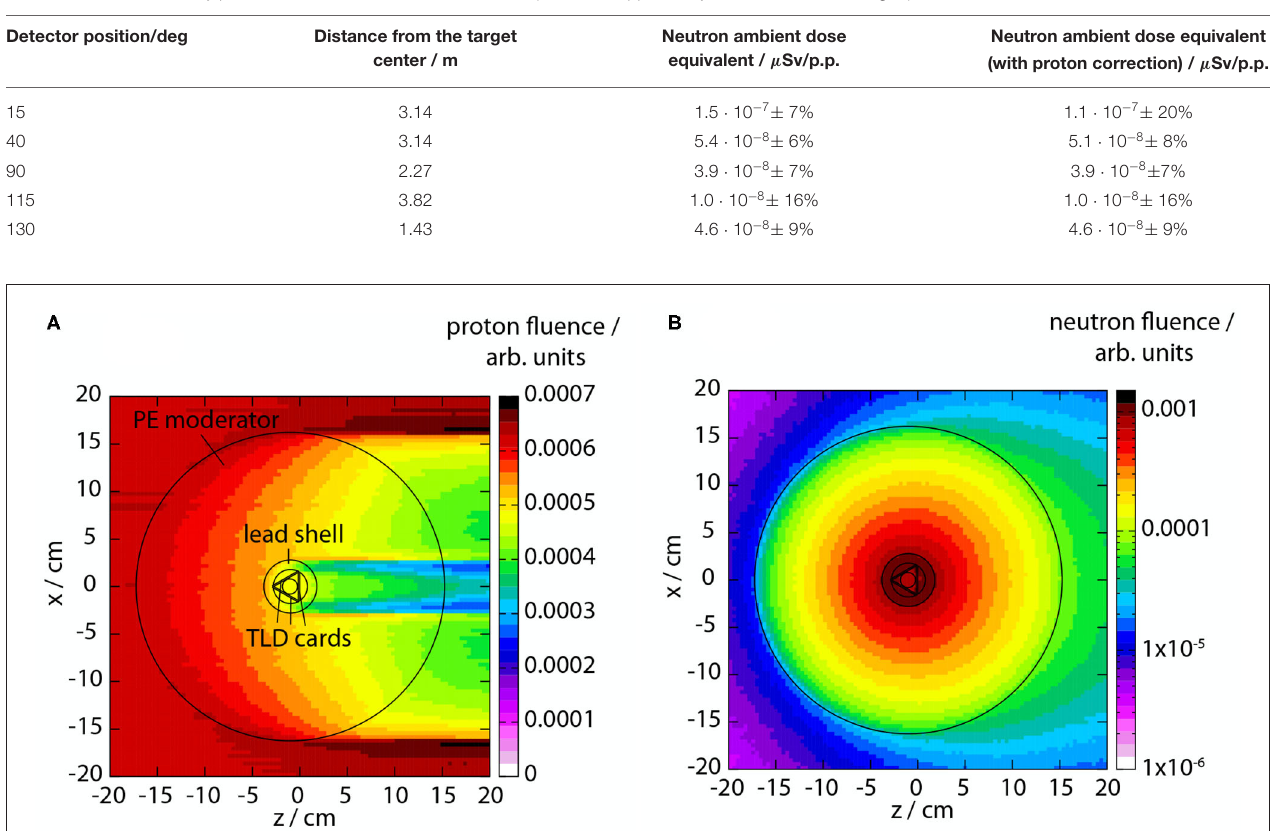
FIGURE 6 | (A) Secondary proton field impinging on the dosimeter and (B) simulated neutron field generated by the proton interaction with the dosimeter moderator.